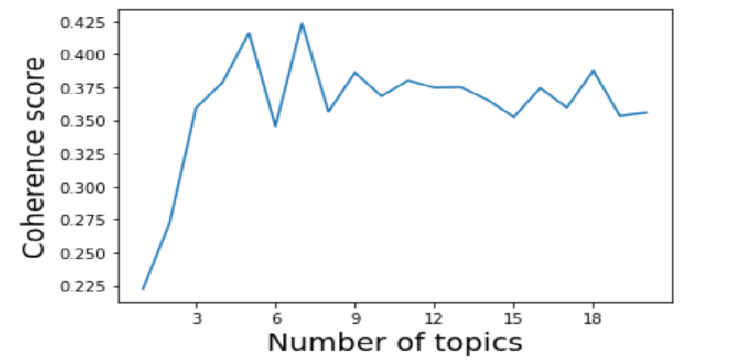
Figure 12. Determining optimal number of